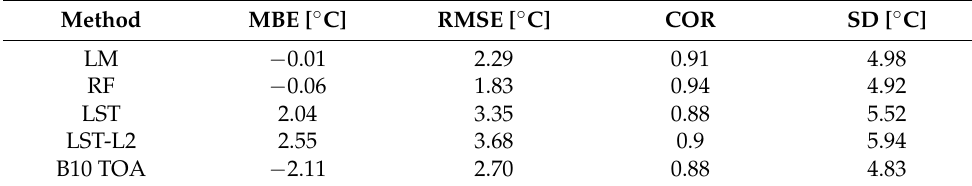
Table 1. Statistics comparing model performance on a test set. The last row with band 10 Top of Atmosphere Reflectance (uncalibrated) is given as a